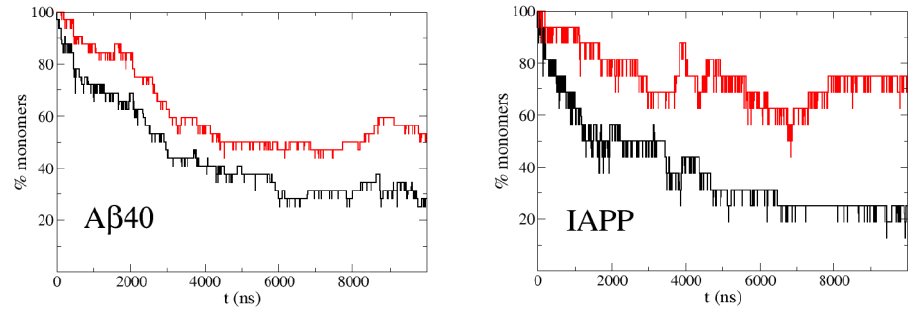
Figure 2. Percentage of monomers in simulations of the highly aggregating peptides A β 40 at 30 µ M concentration ( left ) and IAPP at 100 µ M ( right ) with the original PACSAB force field parametrization (black line) and with the new PACSAB force field (red line).